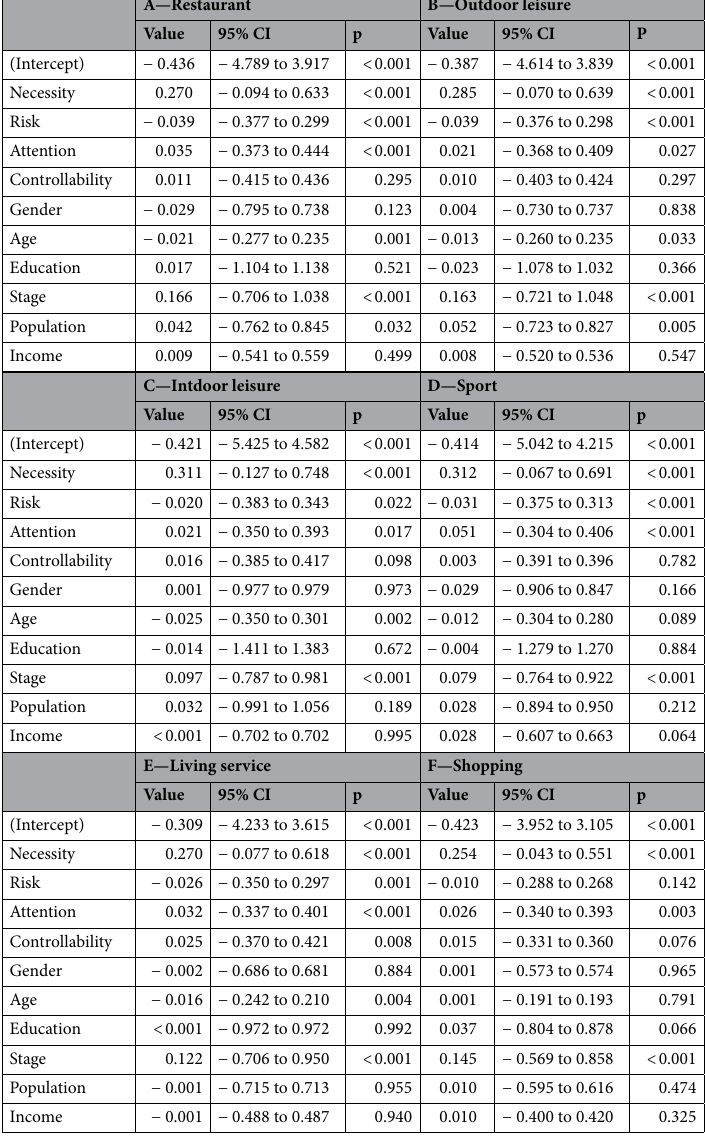
Table 2. GLMM model of willingness.